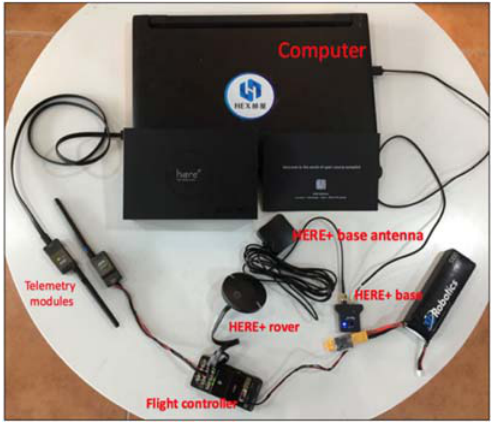
Figure 3. Drone RTK navigation and telemetry systems.